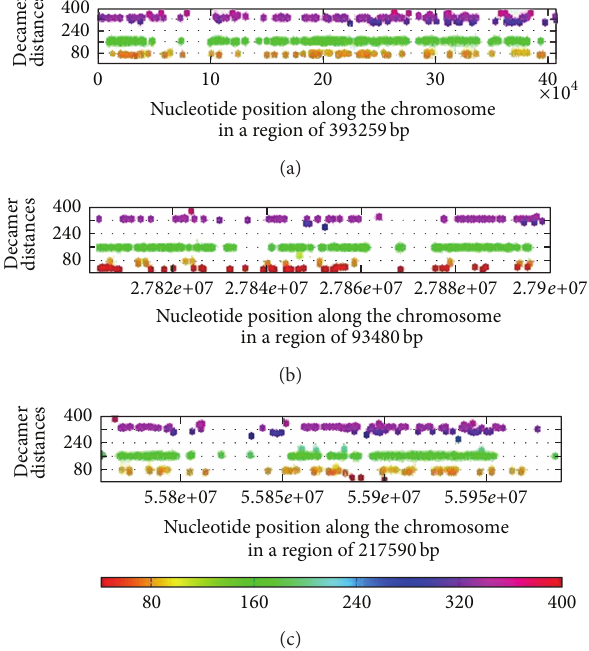
Figure 10: The three main regions of human chromosome 19, where distances around 80, 160, and 320 between the generic decamer are more highly concentrated than in the rest of the chromosomes are highlighted. Note that the clusters correspond to the peaks observed in their respective MIF